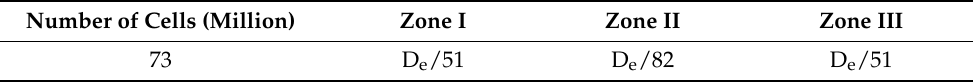
Table 3. Grid refinement